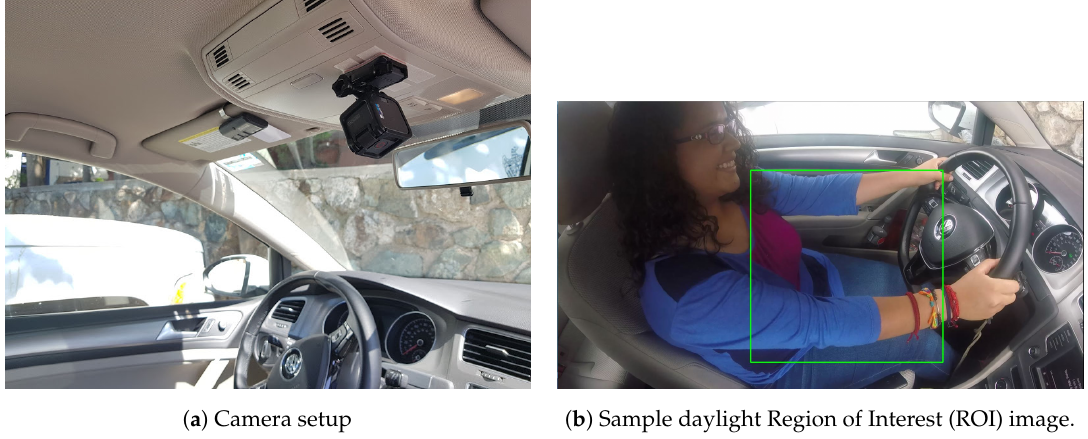
Figure 2. Image acquisition